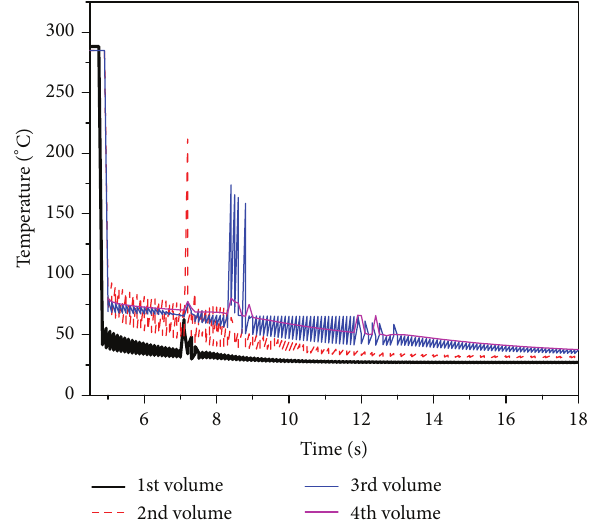
Figure 13: Transient coolant temperature in different volume.